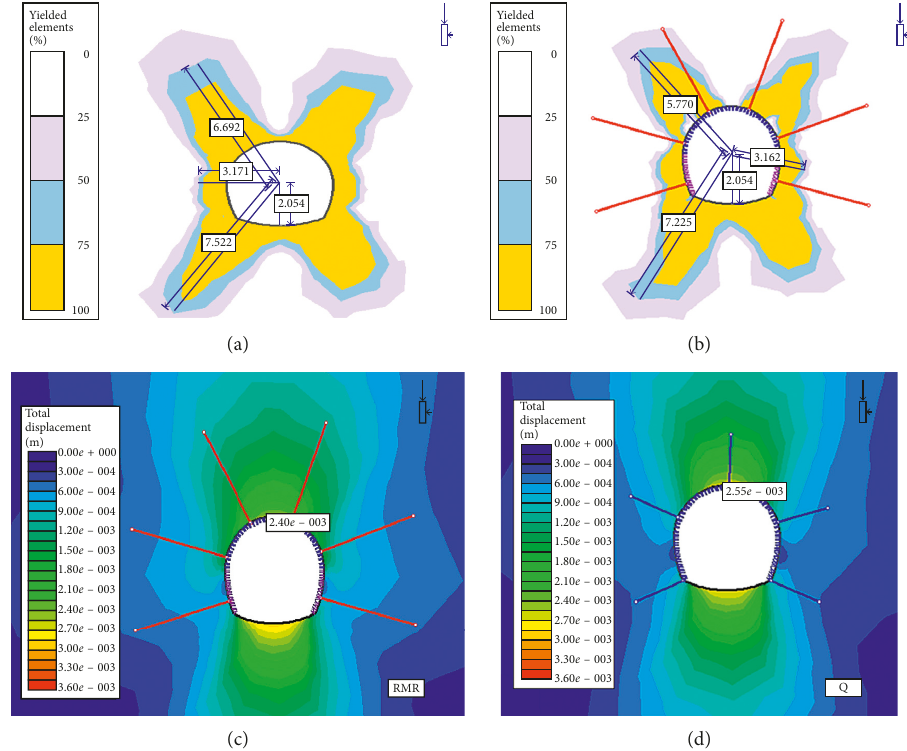
Figure 5: Yield elements and yield zone (50%) after RMR (a) and Q (b) supports. Total deformation after RMR (c) and Q (d)